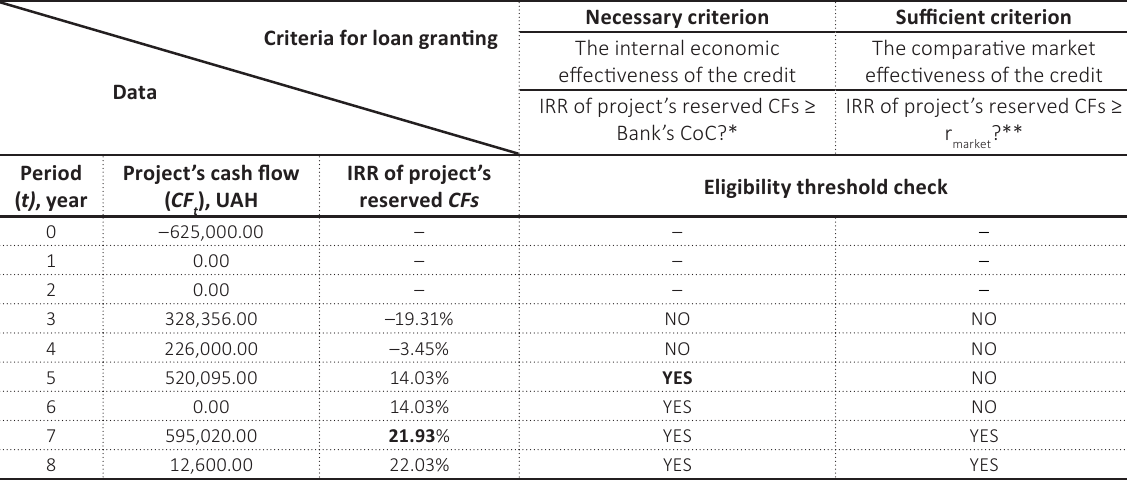
Table 4. Numerical illustration: Lending capacity assessment and loan terms calculation for the case when the potential borrower’s cash flows intended for loan servicing are not regular